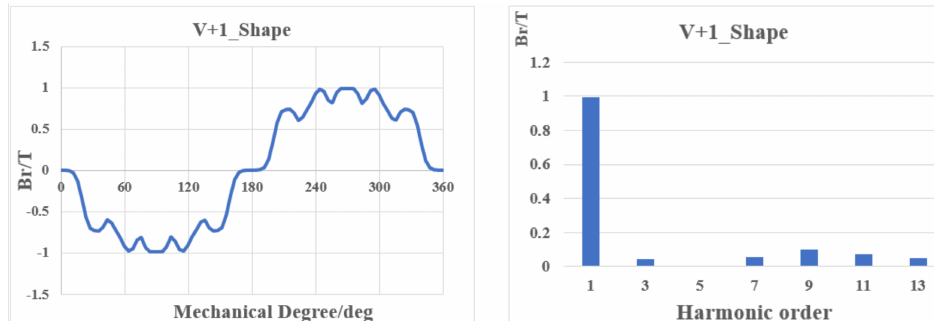
Figure 3. Br and its FFT of V + 1-shaped rotor.